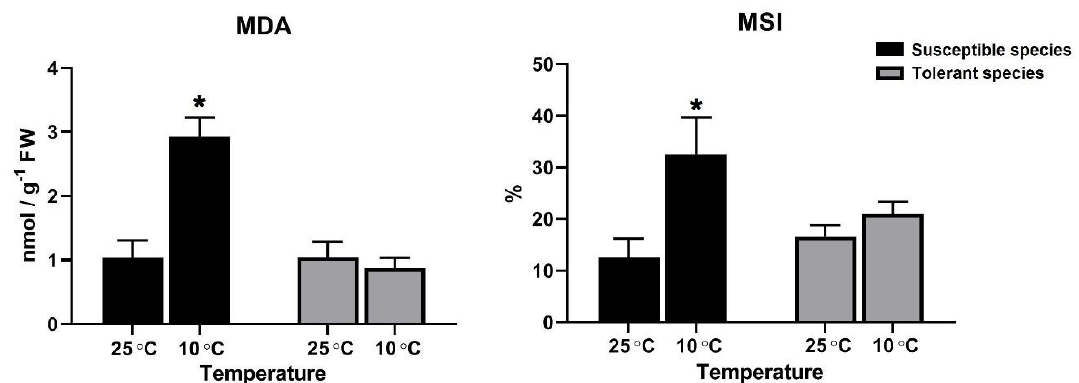
Figure 3. Effects of low temperature (10 °C for three days) on malondialdehyde (MDA) content (nmol/g −1 FW) and membrane stability index (MSI %). An asterisk above a bar shows a significant difference ( p -value < 0.05) between the low-temperature and normal-temperature treatments ( n = 4) (according to Student’s t -test).